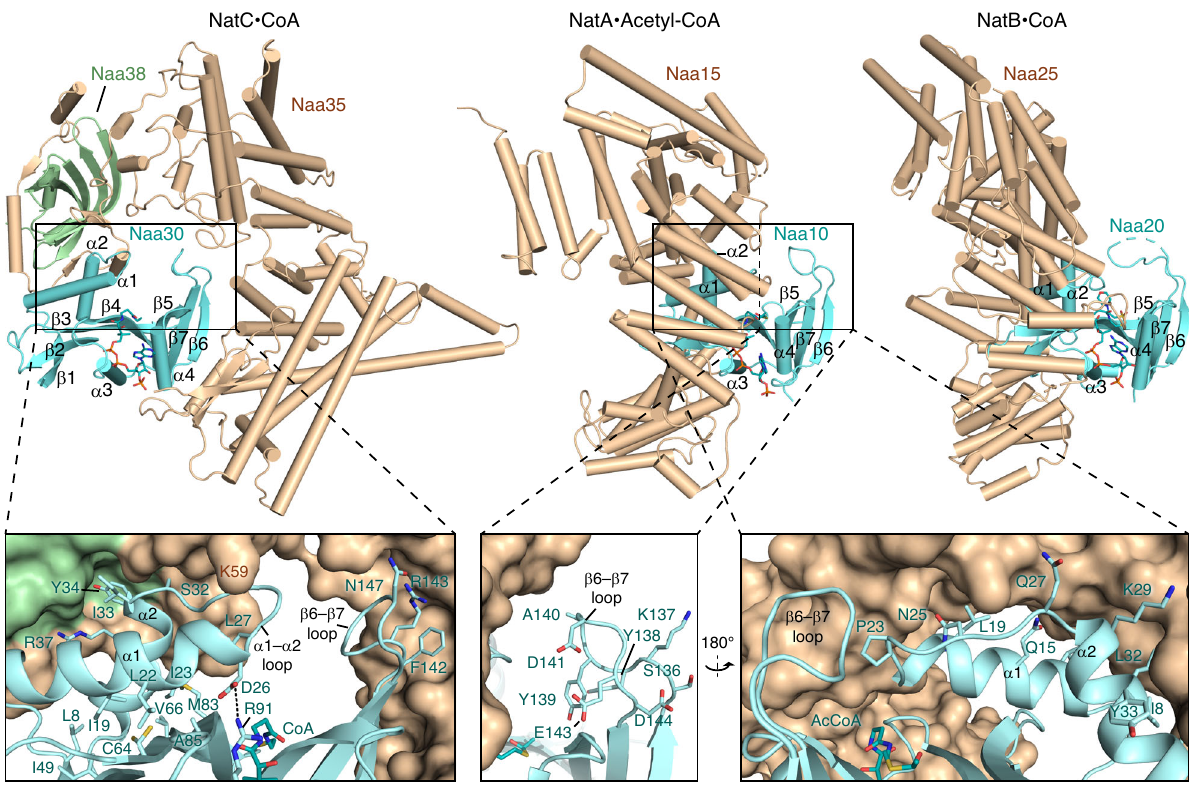
Fig. 2 Structural comparison of the NatC complex. Comparison of CoA-bound S. cerevisiae NatC with acetyl-CoA-bound S. pombe NatA (pdb code 4KVO) and CoA-bound Candida albicans NatB (5K04). The catalytic subunits (cyan) are in the same orientation. The boxed areas are magni fi ed at the bottom and show the interactions of the α 1 – loop – α 2 segment and β 6 – β 7 loop (cartoon representation), with the auxiliary subunits (surface